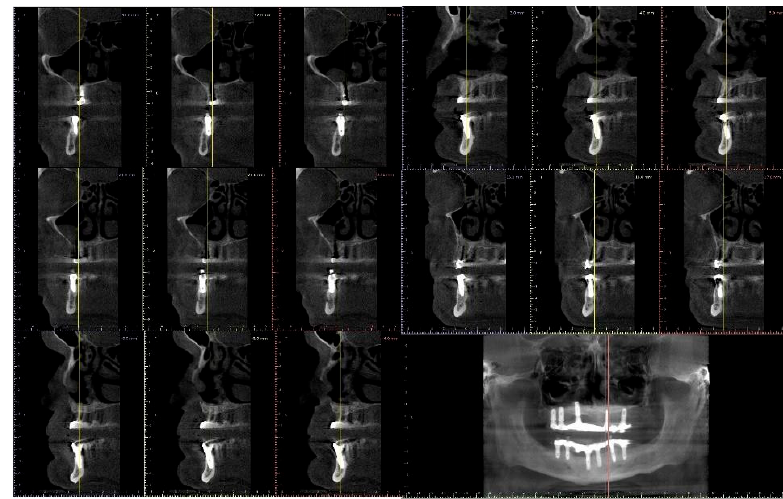
Figure 8. CBCT Panorex projection of the clinical case at the follow up.